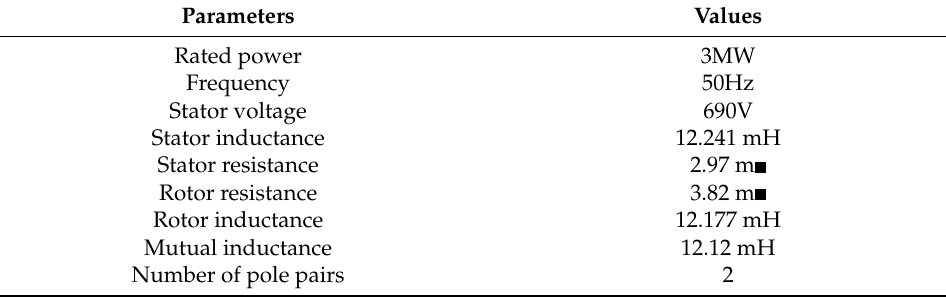
Table 3. Doubly fed induction generator